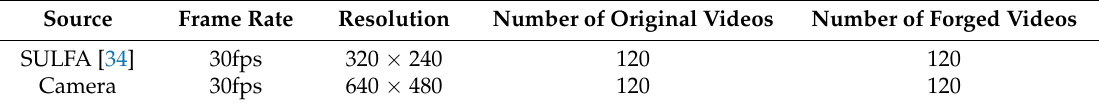
Table 1. The composition of the second video